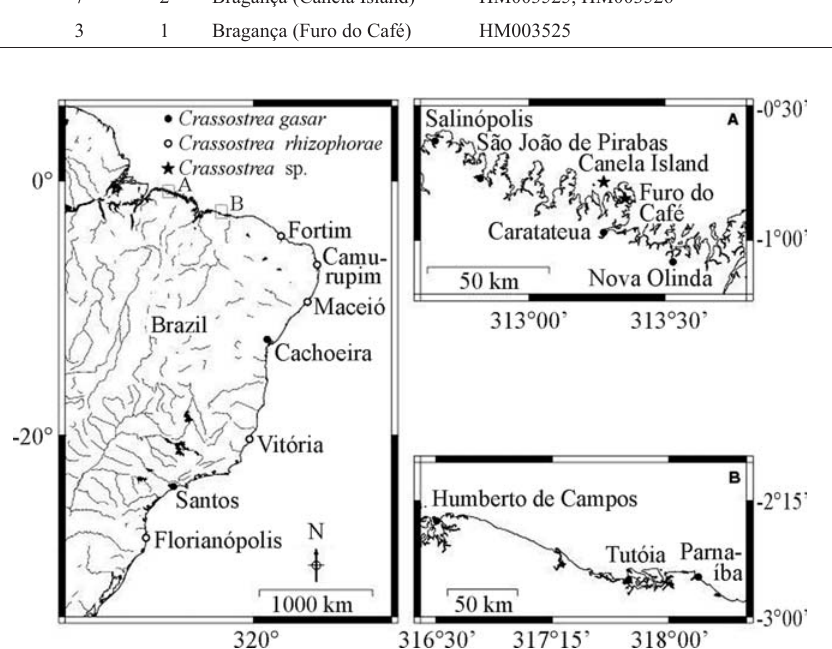
Figure 1 - Map of Brazil indicating the sampling locations for mangrove